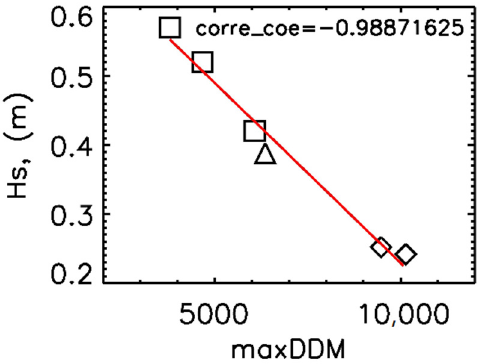
Figure 15. Comparison between the Hs of a buoy and maxDDM (Chimei, Pratas, and Drifter Technology’s buoy are indicated with the diamond, triangle, and